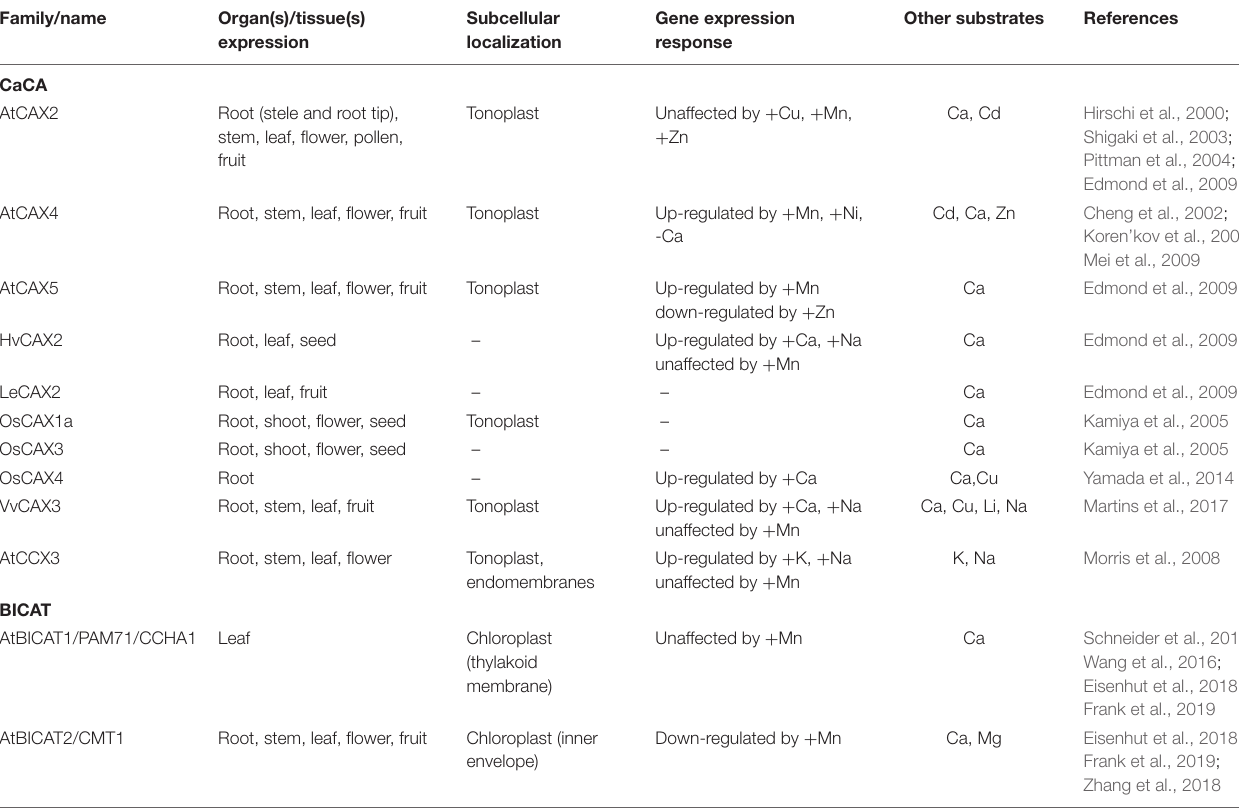
TABLE 1 | Manganese transport proteins reviewed in this